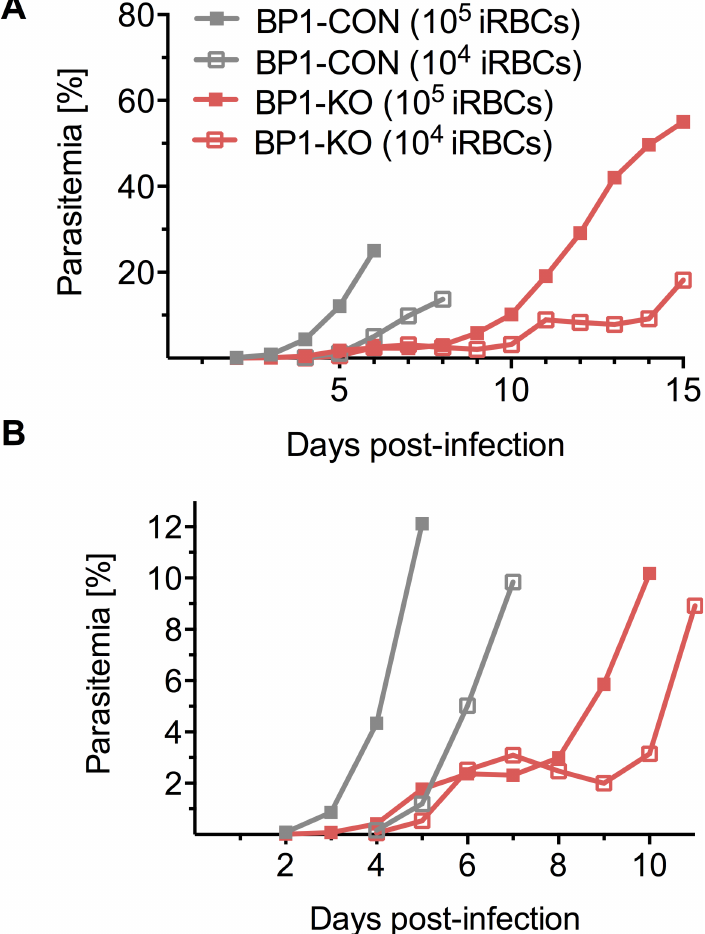
Fig 5. Blood stage growth of berghepain-1 knockout parasitesin mice. 10 4 or 10 5 red blood cells infected with BP1-CON or BP1-KO parasites were injected i.v. into Swiss Webster mice. A. Parasitemiawas monitored daily and the averageparasitemias of 5 mice per group is plotted. B. Data from days 1 through 10 shown in panel A, with an expanded Y-axis to highlightthe differencesin parasitemiain the early stage of infection. Results of a representative experiment, from a total of 2 experiments, using two different doses of BP1-KO clone 1, with a total of 5 mice per group, are